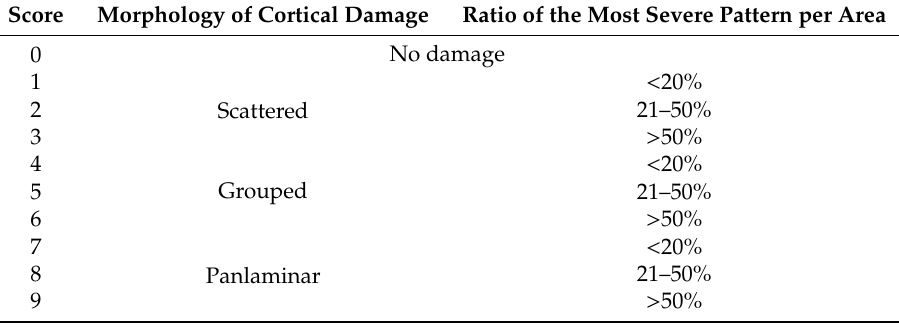
Table 1. Cortical neuronal injury was determined using a neuropathology scoring system based on the occurrence of the most severe pattern observed in 40 visual fields. Higher scores represent more severe neuronal damage. Representative photomicrographs are shown in Supplementary Figure S6. Score Morphology of Cortical Damage Ratio of the Most Severe Pattern per